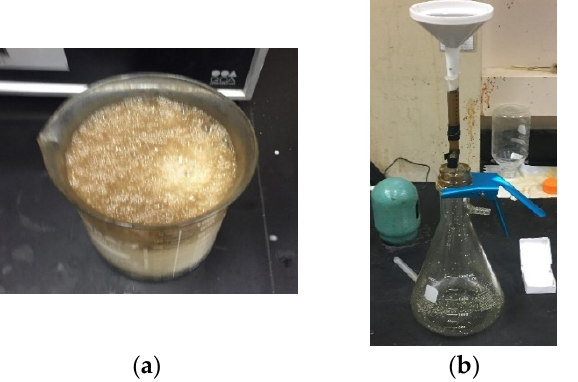
Figure 1. Spent-acid preparation. ( a ) Live acid reacting with Indiana Limestone chunks; ( b ) filter- ing the resulted